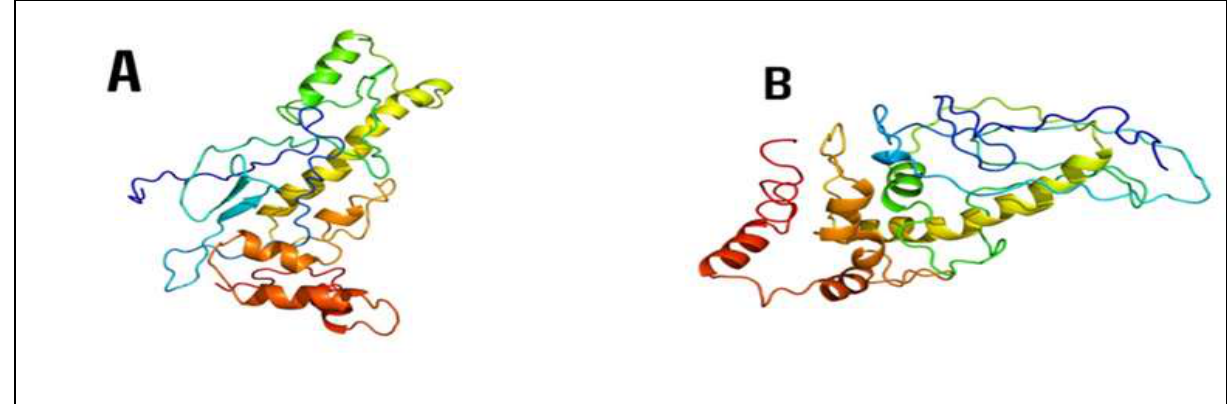
Figure 6: The 3-dimension structure of TCF7L2 protein in A) T2DM Iraqi Patient B) TCF7L2 protein from NCBI